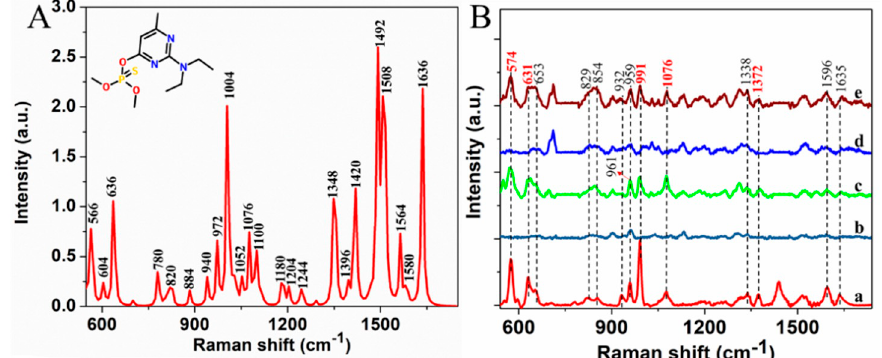
Figure 2. ( A ): Calculated Raman spectra of pirimiphos-methyl using DFT, and the inset is molecular structure of pirimiphos-methyl; ( B ): Raman spectra of pirimiphos-methyl powder ( a ) and SERS spectra of acetone ( b ), pirimiphos-methyl in acetone solution (25 mg/L) ( c ), wheat extraction solutions ( d ) and pirimiphos-methyl in wheat extraction solutions (25 mg/L) ( e ). Table 1. Peak assignment for calculated and experimental Raman peaks of pirimiphos-methyl (cm − 1 ). Calculated Raman Peaks Experimental Raman Peaks Assignment